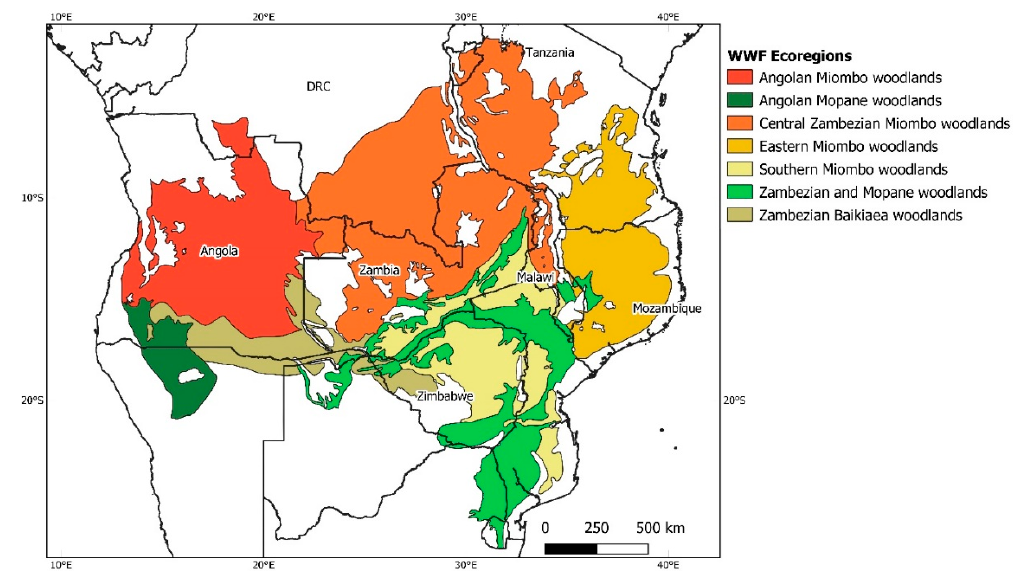
Figure 1. Geographical distribution of the Miombo–Mopane woodlands in the Zambezian phytoregion.